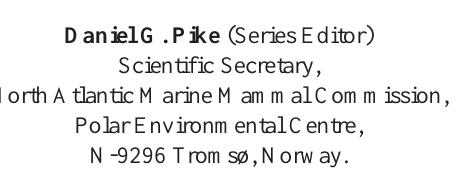
Cover Illustration: Artist Lucy Bergström painted this interpretation of sealworm life